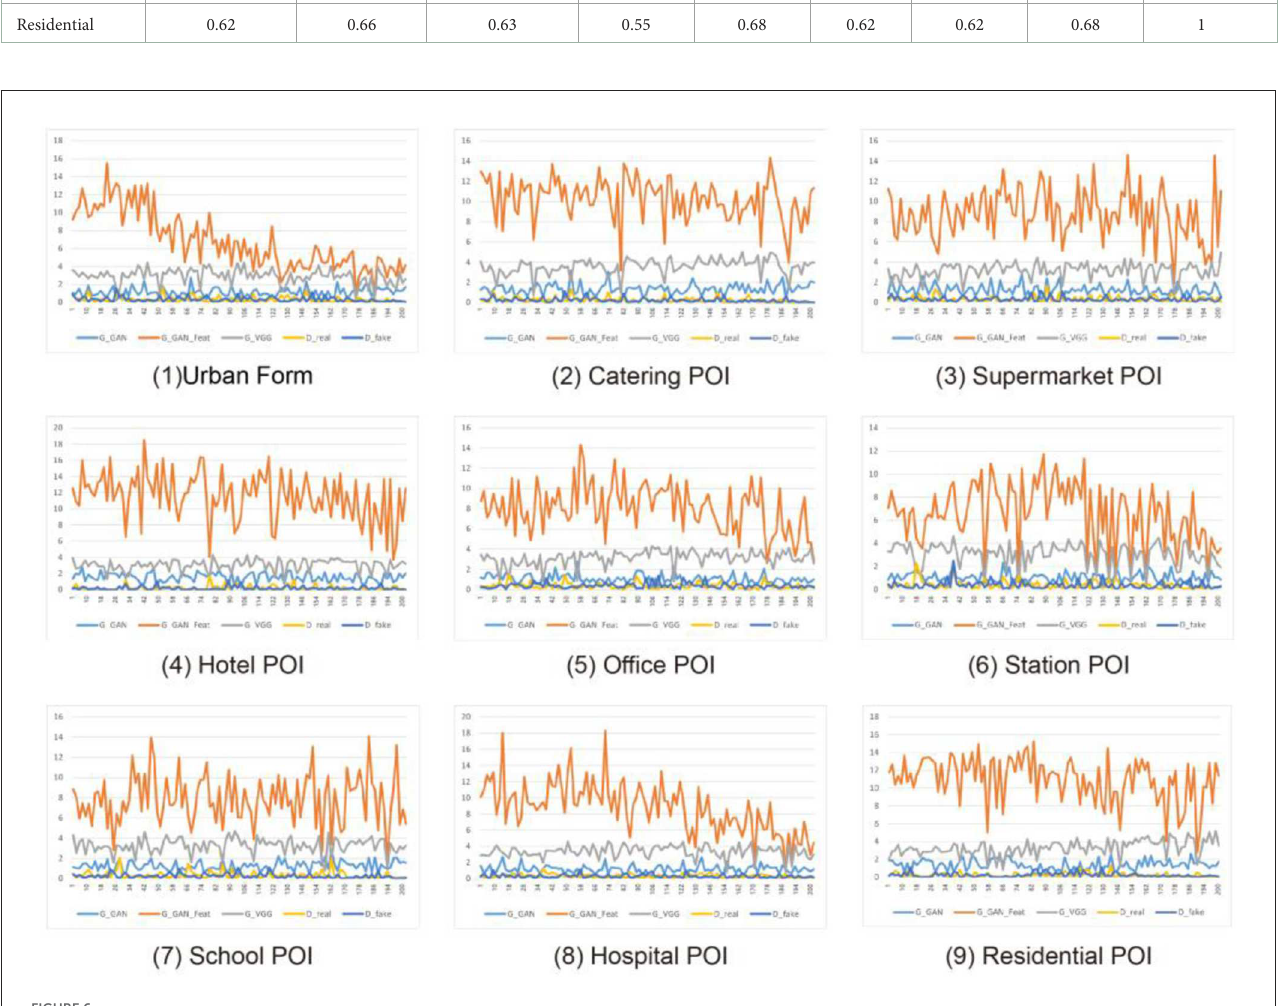
as input data indicates that they are relatively weakly related to the COVID-19